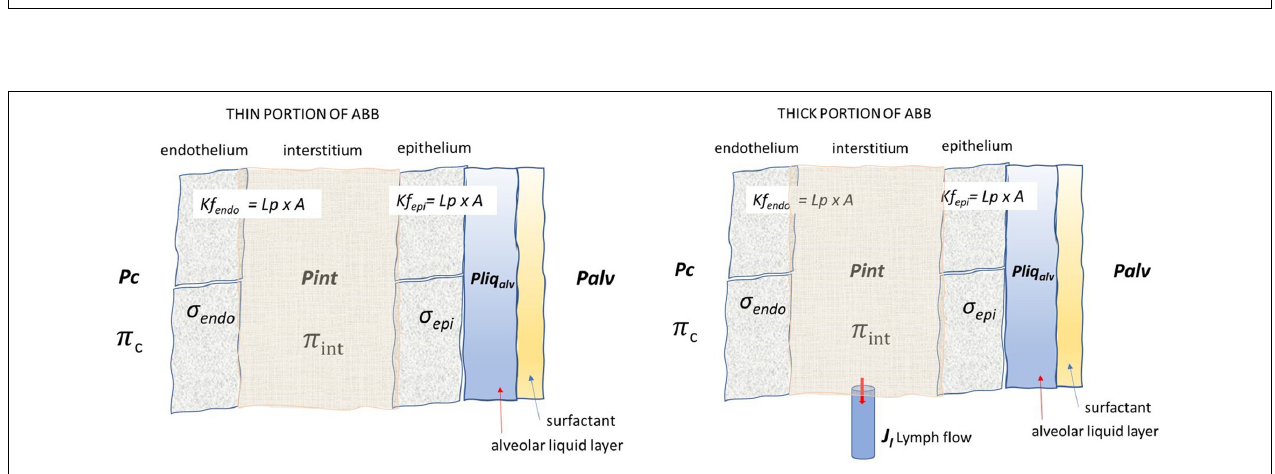
FIGURE 3 | Lung fluid compartments of the ABB and parameters governing fluid exchanges. Pc, Pint, and Pliq alv are capillary, interstitial, and alveolar liquid hydraulic pressure, respectively; (cid:53) c and (cid:53) int are capillary and interstitial oncotic pressure, respectively; σ endo and σ epi are the protein reflection coefficient of endothelium and epithelium, respectively; Palv is the alveolar pressure; Lp, A, Kf endo , and Kf epi are the hydraulic conductance, overall filtration surface, and endothelial and epithelial filtration coefficient, respectively. Lymphatic drainage (Jl) occurs from the thick portion of ABB where lymphatics are located.